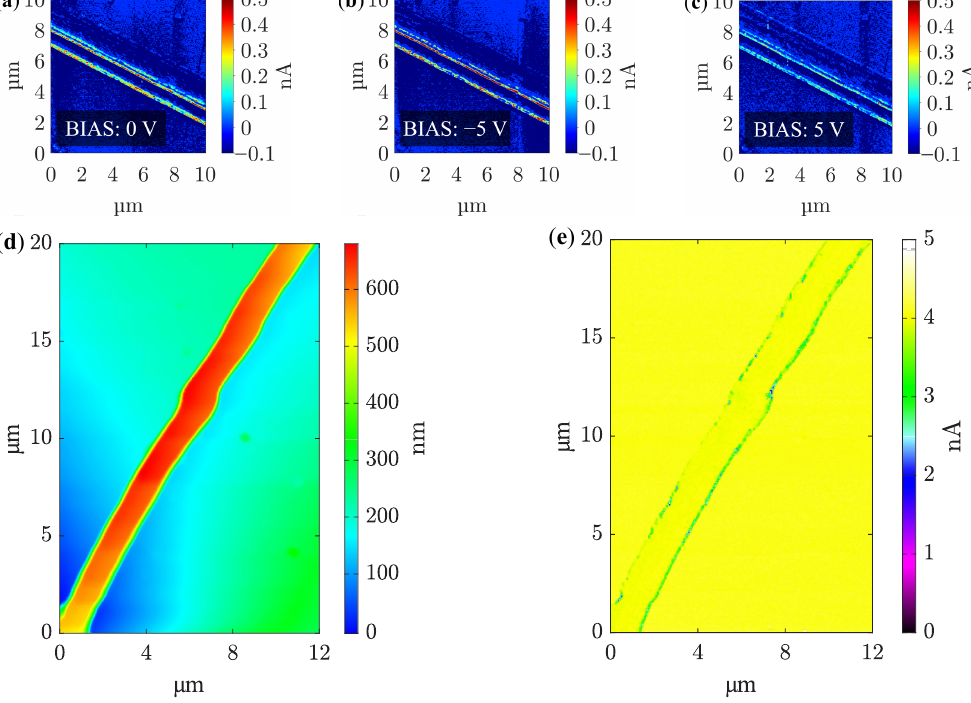
Figure 6. ( a – c ) Piezoelectric response of PVDF nanofiber with the imperfect circular shape at biasing of ( a ) 0V, ( b ) − 5V, and ( c ) 5V. ( d ) Measured fiber morphology and ( e ) electrical response of vertically oriented domains of single fiber by PFM